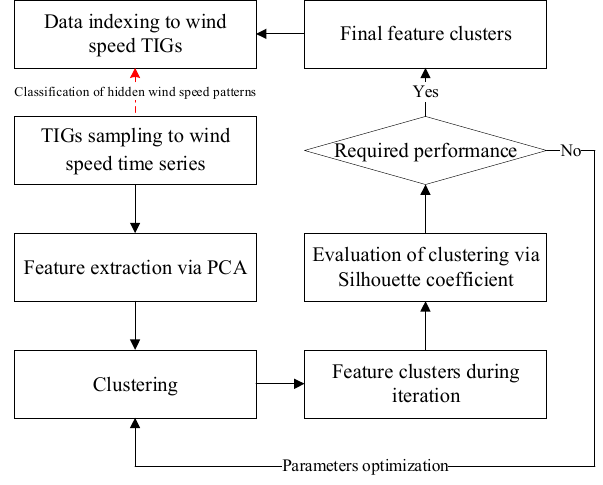
Figure 1. Diagram of classification of hidden wind speed patterns.